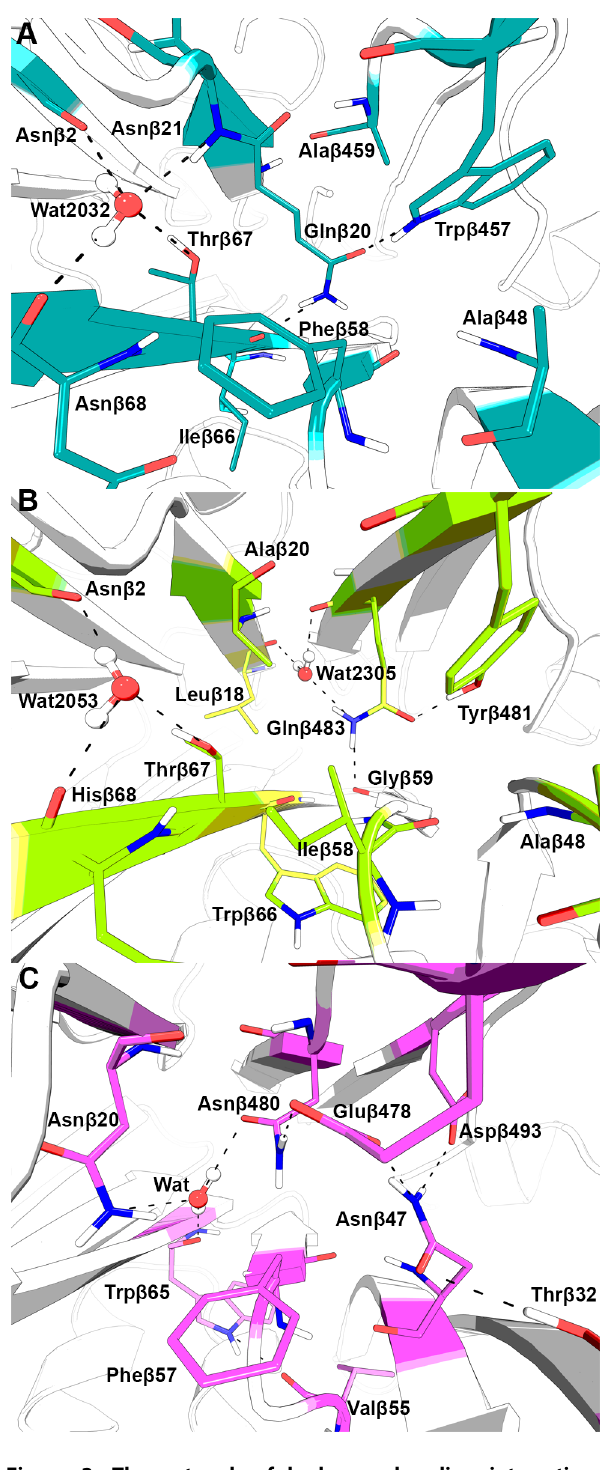
Figure 3. The network of hydrogen bonding interactions between the two b -layers of the abba -core B1 domain in Ntn- hydrolases. (A) Glutarylamidase from Pseudomonas sp ., (B) N-acyl homoserine lactone acylase PvdQ from Pseudomonas aeruginosa , and (C) penicillin acylase from Alcaligenes faecalis .